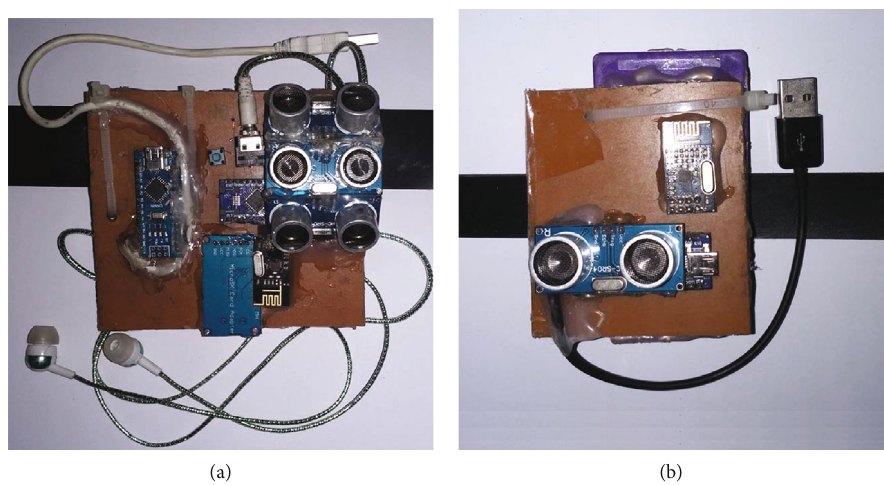
Figure 4: Newly constructed modular assistive device: (a) belt module and (b) ankle